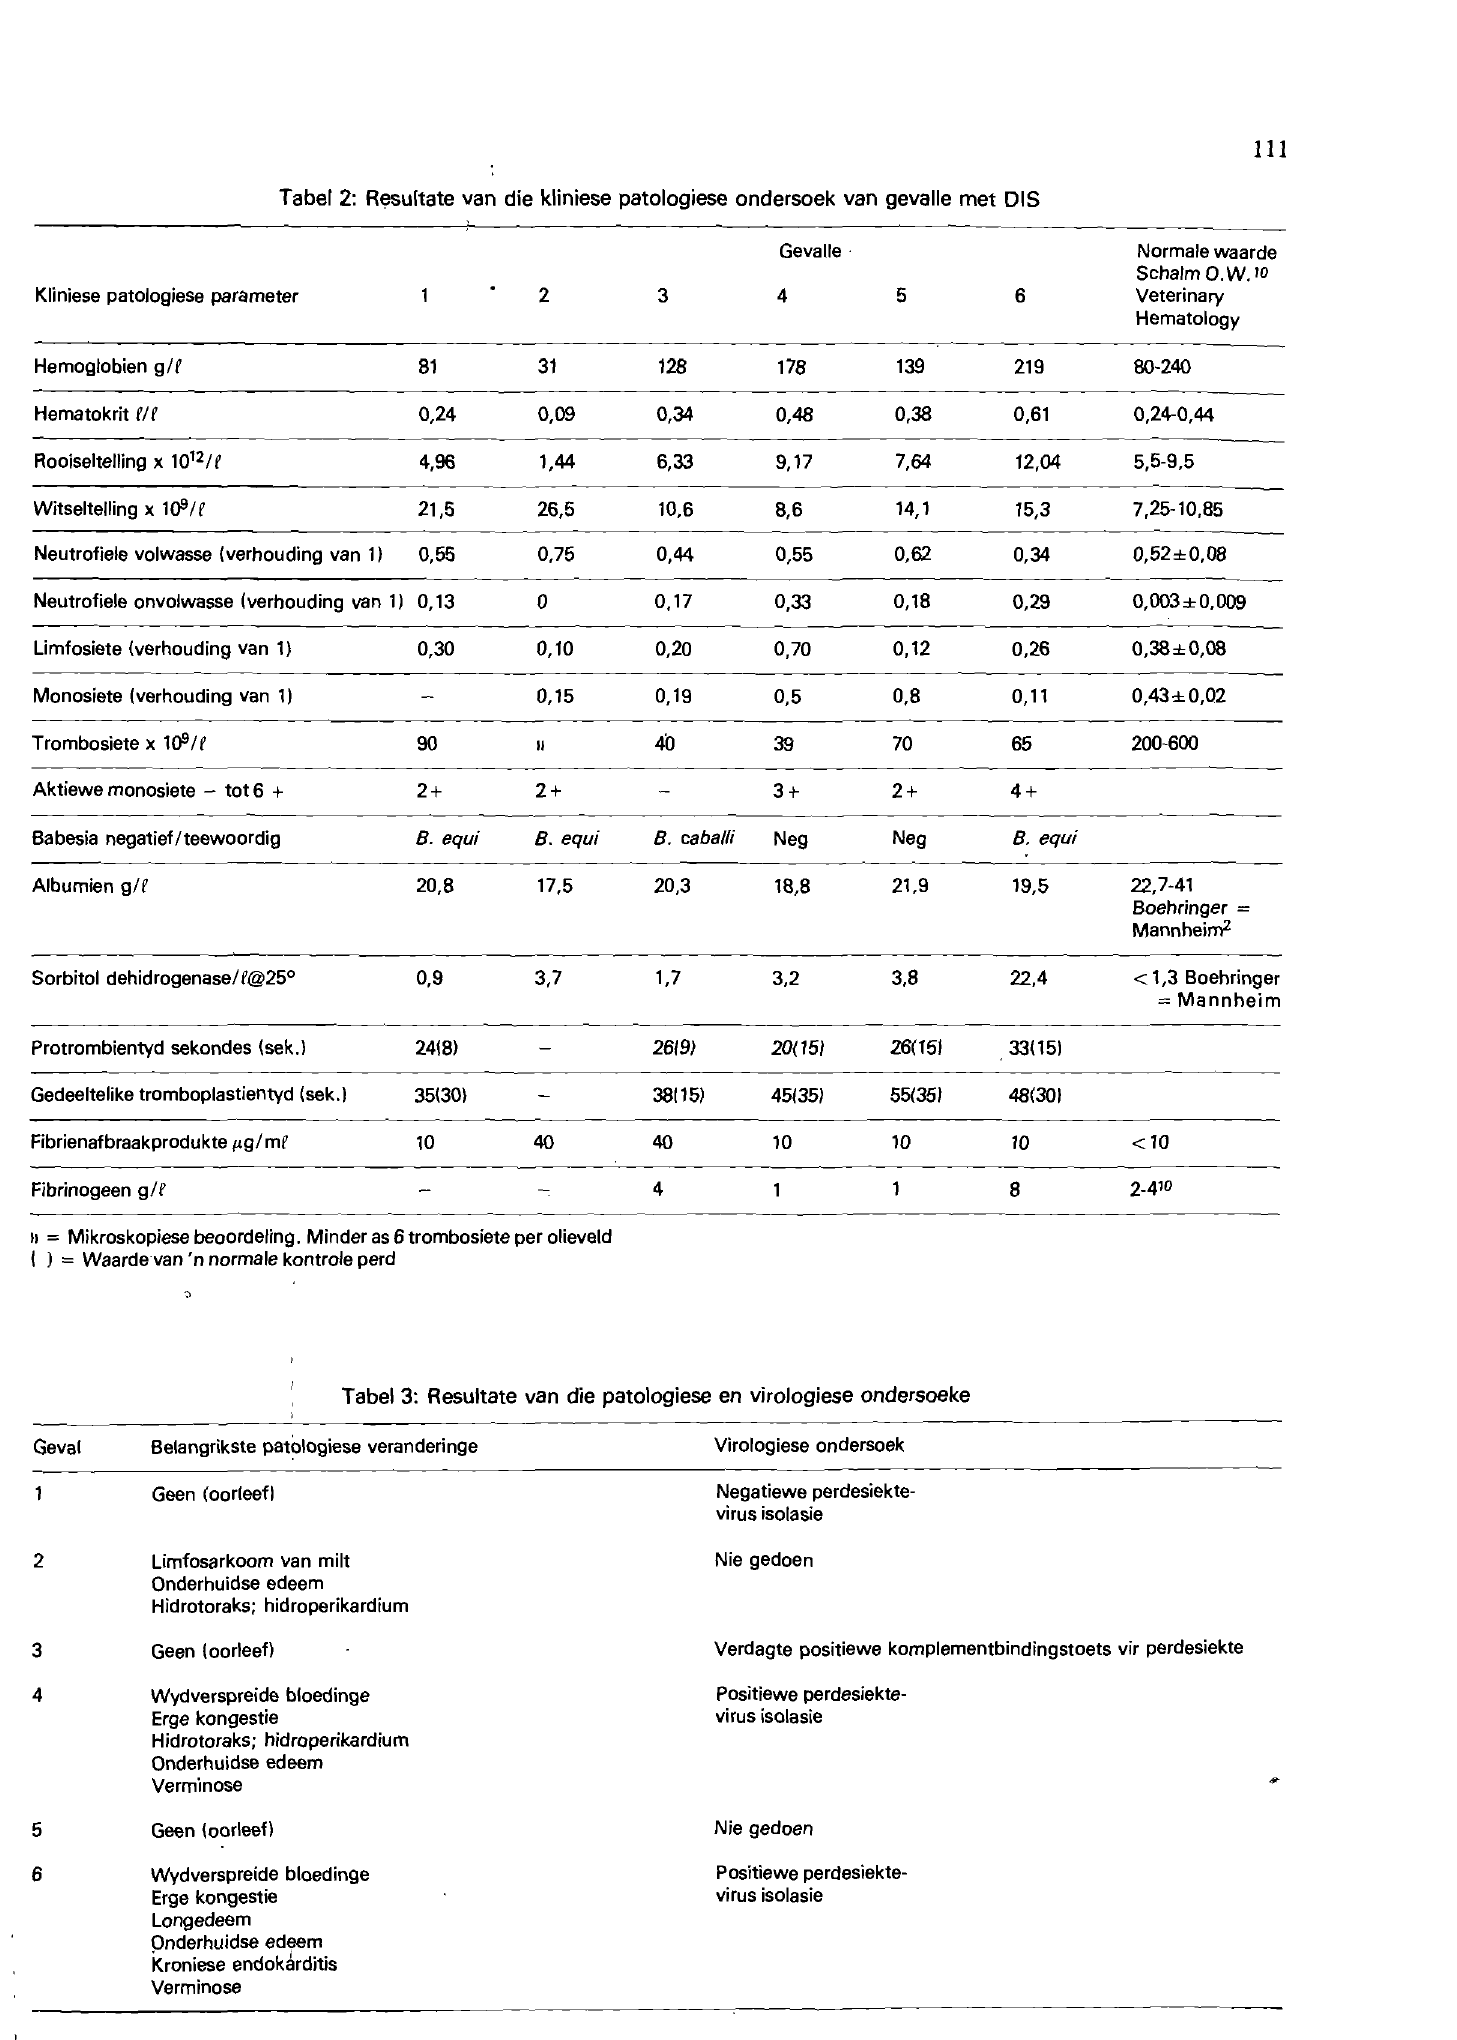
Tabel3: Resultate van die patologiese en virologiese